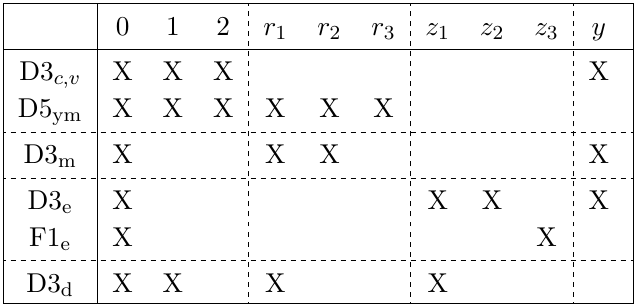
Table 1 . Solitonic